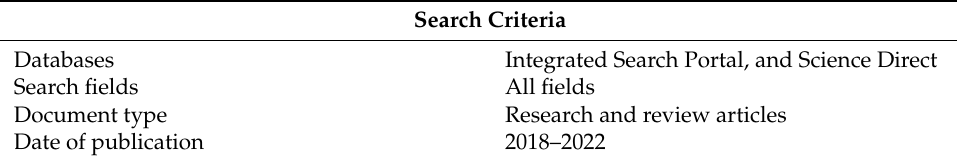
Table 3. Summary of the criteria defined for searching the